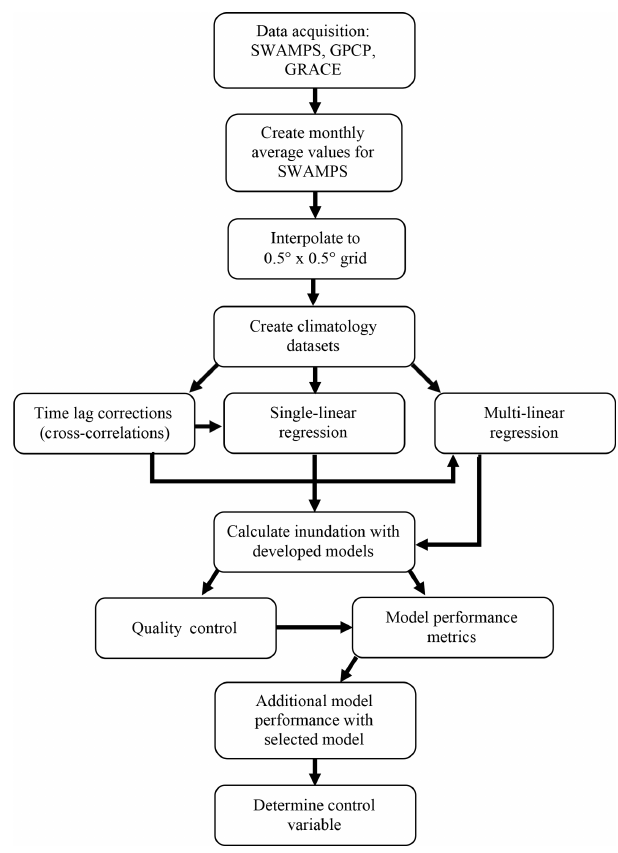
Figure 3. Methodology